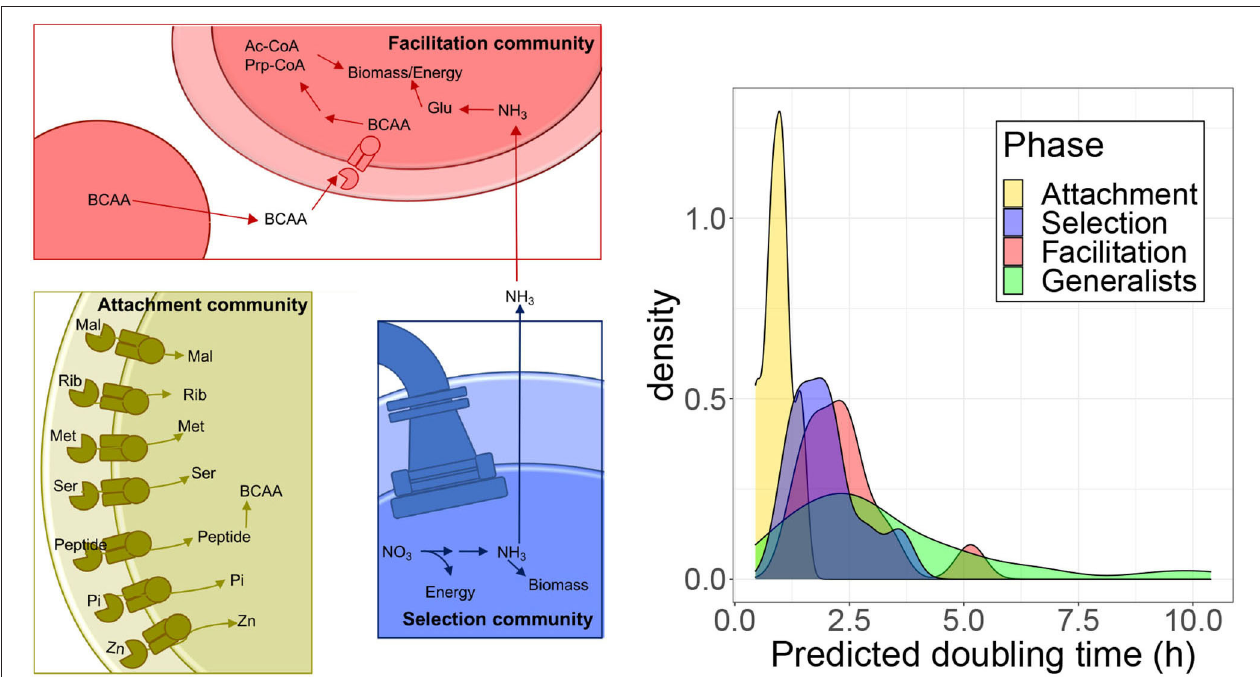
FIGURE 6 | Analysis of specific pathways. (Left) Schematic of enzymatic processes encoded by taxa belonging to the three community types that assemble on polysaccharide particles. Attachment communities (gold) that are the first to form on particles and commonly encode a diverse array of high-affinity ABC transporters, specific for sugars, such as maltose (Mal) and ribose (Rib), amino acids including methionine (Met) and serine (Ser), transporters specific to small peptide signals/antimicrobials, inorganic phosphate (Pi), and zinc (Zn). They also have genes to synthesize BCAA. Selection communities (Blue) form in between attachment and facilitation communities. Taxa in these communities frequently encode flagella and chemotaxis genes and perform dissimilatory nitrate reduction generating ammonia. Facilitation communities (Red) are the last to form on particles and encode pathways that break down BCAA into acetyl-CoA (Ac-CoA) and propanoyl-CoA (Prp-CoA), metabolites that can enter central metabolism to make biomass or energy. Taxa in facilitation communities also commonly encode glutamine and glutamate (Gln) synthases and glutamine synthetase, which are the main pathways for the assimilation of ammonia-derived nitrogen into biomass. (Right) Predicted doubling times of isolates estimated from ribosomal proteins codon usage bias with